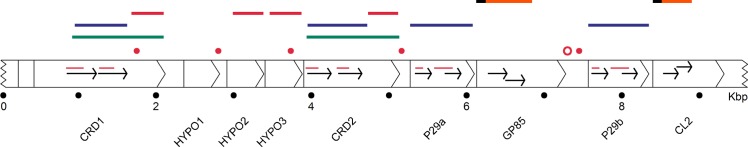
Appendage genes and proteins.Appendage protein genes P29a, P29b and GP85 and related genes (open arrows) reside on a 9.6 Kbp region of the chromosome and are transcribed in the same direction (arrow points). Extensive homology of the deduced proteins (or regions therein) is indicated by colored bars above the relevant portions of the genes: CRD1 and CRD2 (green), portions of CRD1 and CRD2 with most of P29a and P29b (blue), portions of CRD1 and CRD2 with most of the HYPO2 and HYPO3 proteins (red) and portions of GP85 and CL2 are identical (black) and both have collagen-like regions (orange). Internal repeats and DUF11 sequences within deduced protein sequences are indicated by black arrows and red bars, respectively. Positions of potential mother cell late promoters (red circle) and a potential sigma A-dependent promoter (open red circle) are indicated. The filled circles indicate Kbp positions. Bp 1 corresponds to the complement of chromosomal nucleotide pair 2,172,100.